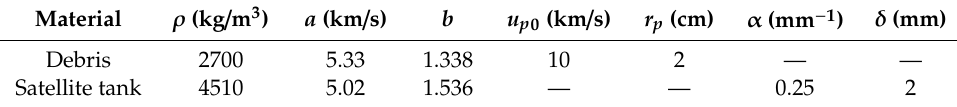
Table 8. Comparison of the simulation results and calculation results.